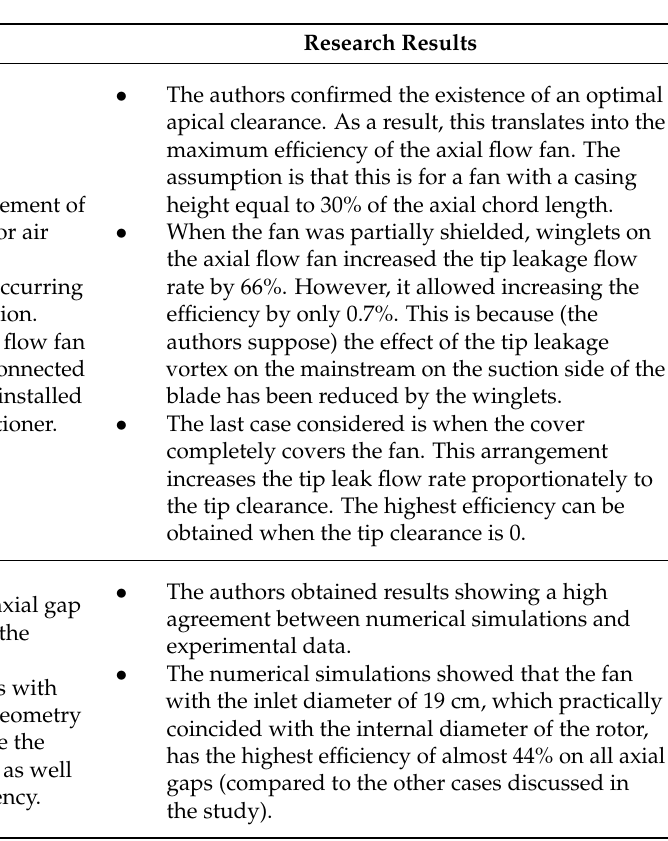
Table 1. List of measures taken to improve fan energy